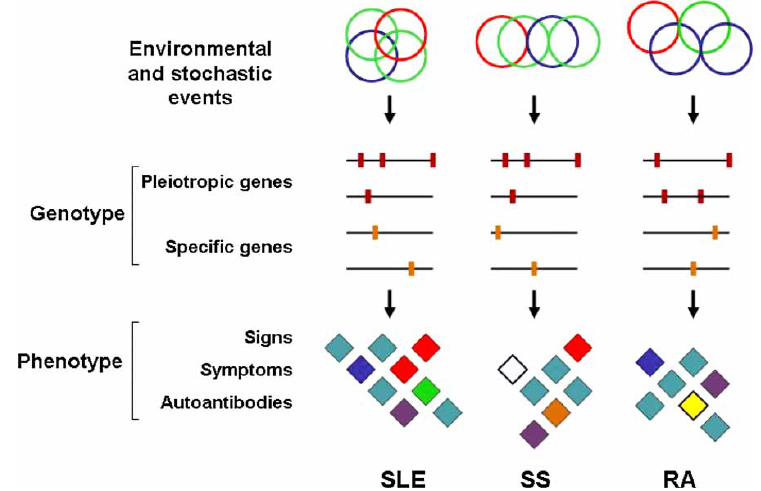
Figure 1. The common origin for diverse ADs hypothesis. ADs are the result of multiple interactions of polymorphic genes and environmental or stochastic factors leading to a loss of immunological tolerance to self-antigens and then to tissue damage. The genetic risk factors for ADs may well consist of two forms: those which are common to many ADs acting in pleitropy, and those that are specific to a given disorder. SLE: systemic lupus erythematosus, SS: Sjo¨gren’s syndrome, RA: rheumatoid arthritis.